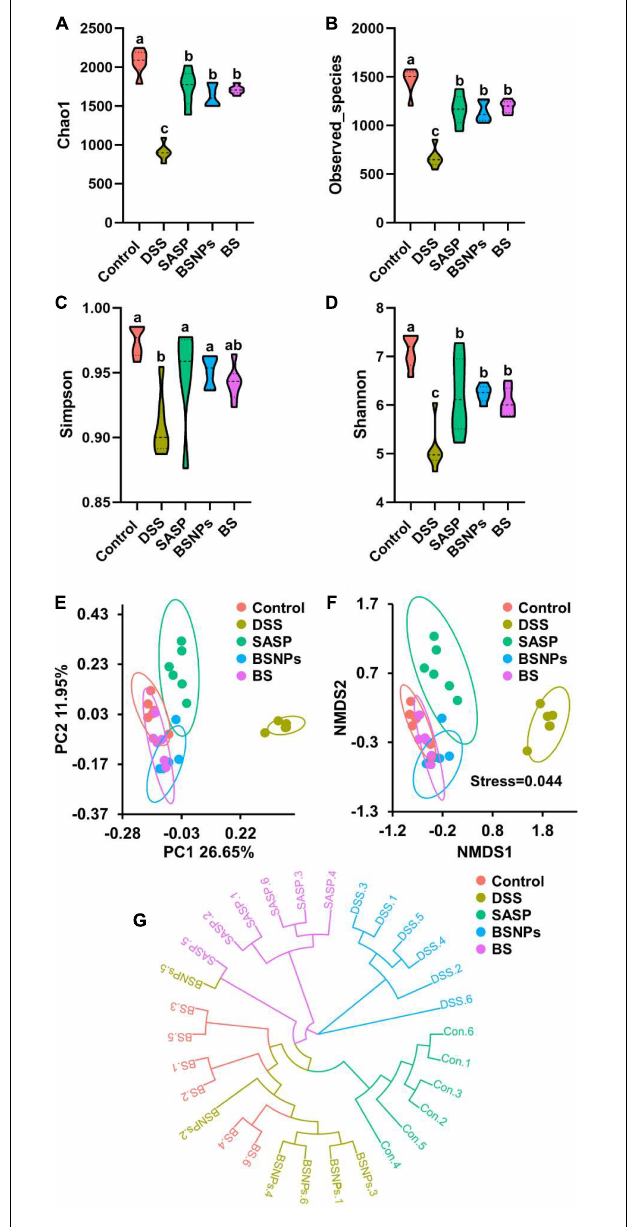
FIGURE 3 | Analysis of the alpha diversity and beta diversity of the differential microbial community among the control group, DSS group, SASP, BS, and BSNPs-treated group. Violin plots showing Chao1 index (A) , Observed_species index (B) , Simpson index (C) , Shannon index (D) . (E) UniFrac distance of unweighted PCoA analysis, (F) UniFrac distance of unweighted NMDS analysis, (G) the unweighted pair-group technique with arithmetic mean (UPGMA) analysis the differences between samples. Means without a common letter are significantly different at p < 0.05 using one-way ANOVA followed by Tukey’s test for post hoc